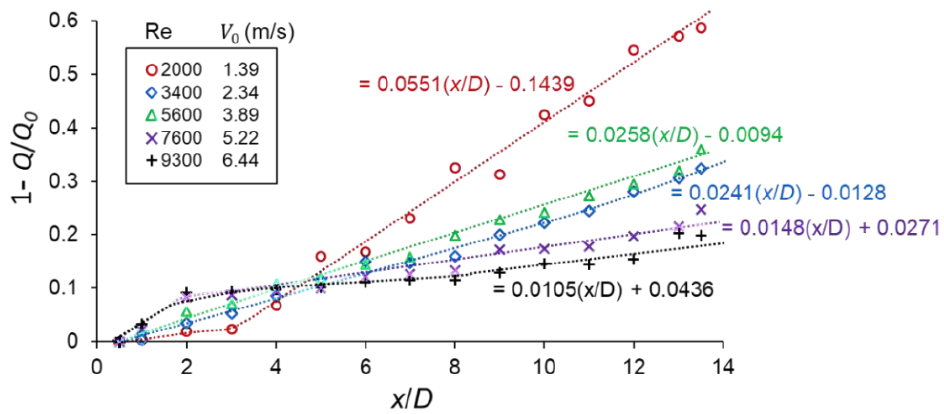
Figure 11. Jet and ambient mixing as a function of downstream distance.